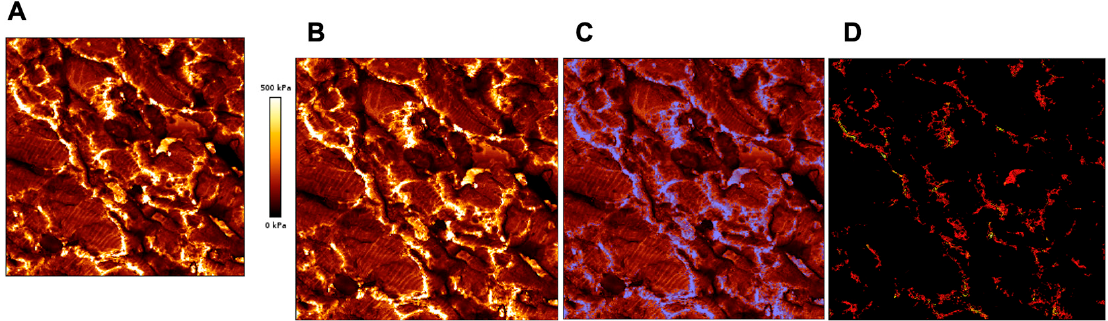
Figure 8. Representative image of the Matlab segmentation approach. Panels from left to right show: ( A ) original JPK image, ( B ) cropped image to removed scale, ( C ) cropped image with binary mask overlayed (blue) and ( D ) contour plot of isolated region.